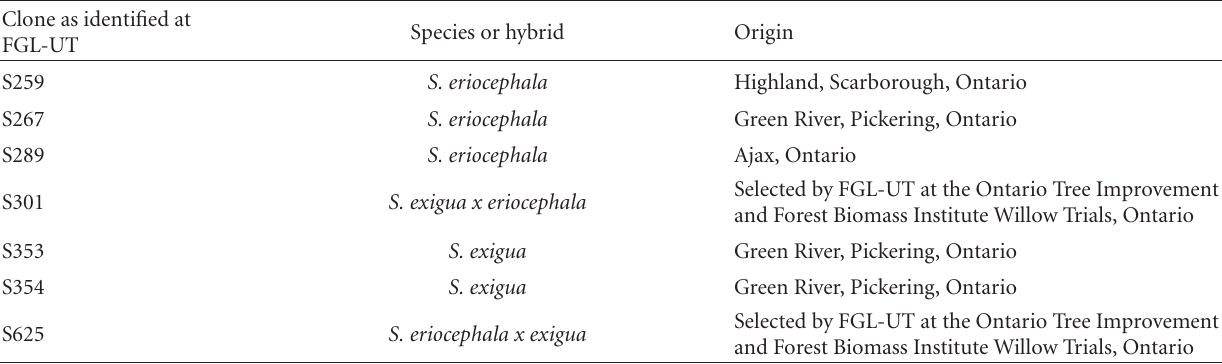
Table 1: List of the Salix clones studied and their origin.